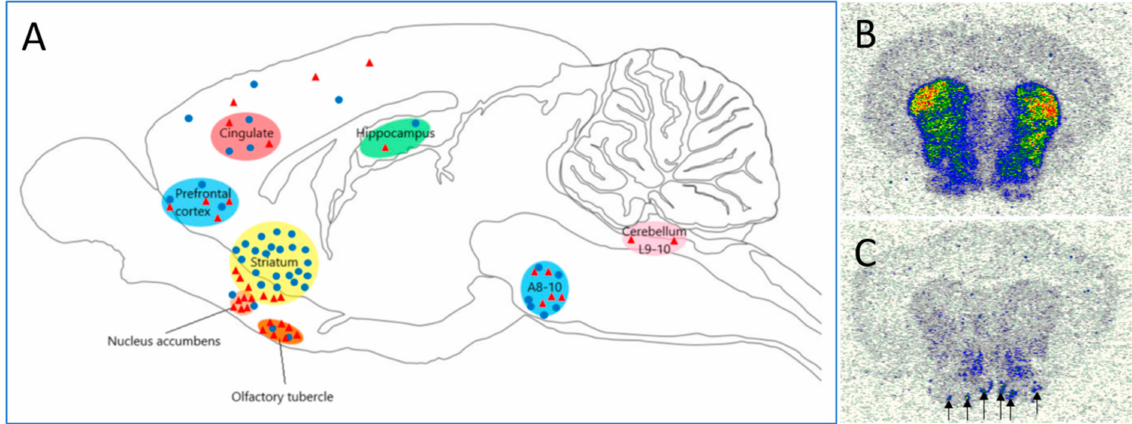
Figure 1. ( A ) D2Rs (blue circles) and D3Rs (red triangles) show distinct distribution within the rat brain (schematic drawing of the median sagittal section of a rat brain modified from the original image created by Gill Brown (source: neuroscience- graphicdesign.com, license: CC BY-NC 4.0). ( B ) [ 3 H](+)PHNO binding in rat brain coronal section in the absence Gpp(NH)p visualizes both D2Rs and D3Rs. ( C ) [ 3 H](+)PHNO binding in rat brain coronal section in the presence of 100 µ M Gpp(NH)p allows visualization of only D3Rs. Arrows indicate the islands of Calleja, an area in the olfactory tubercle rich in D3Rs. The remaining binding dorsally to the islands of Calleja in the nucleus accumbens indicates high abundance of D3Rs in this area. Autoradiograms by F. Horti and B. Kiss